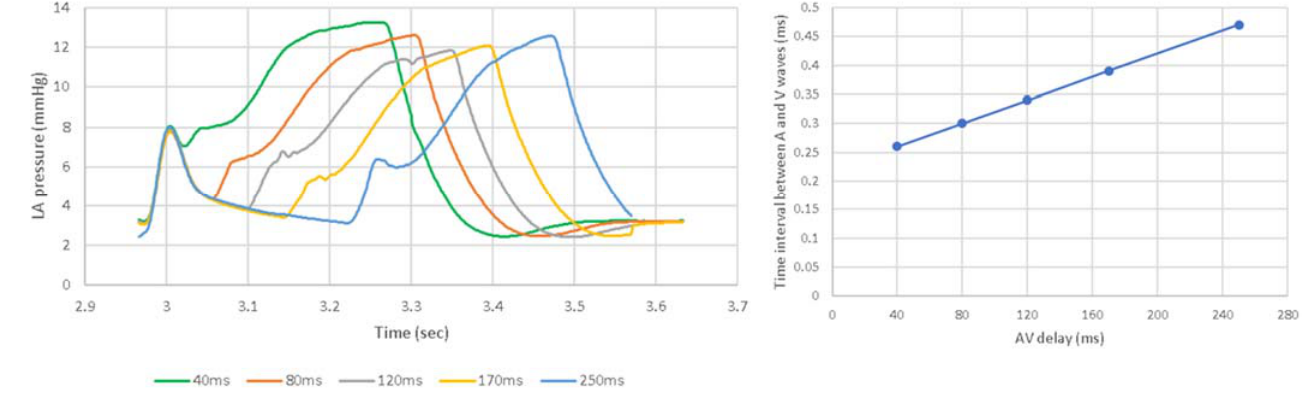
Figure 8. ( Left ) Pressure time traces for left atrium at the fifth cardiac cycle. ( Right ) Time interval between the peaks of LA pressures at A wave and V wave with heart rate of 90 bpm and AV delay of 40, 80, 120, 170, 250 ms.